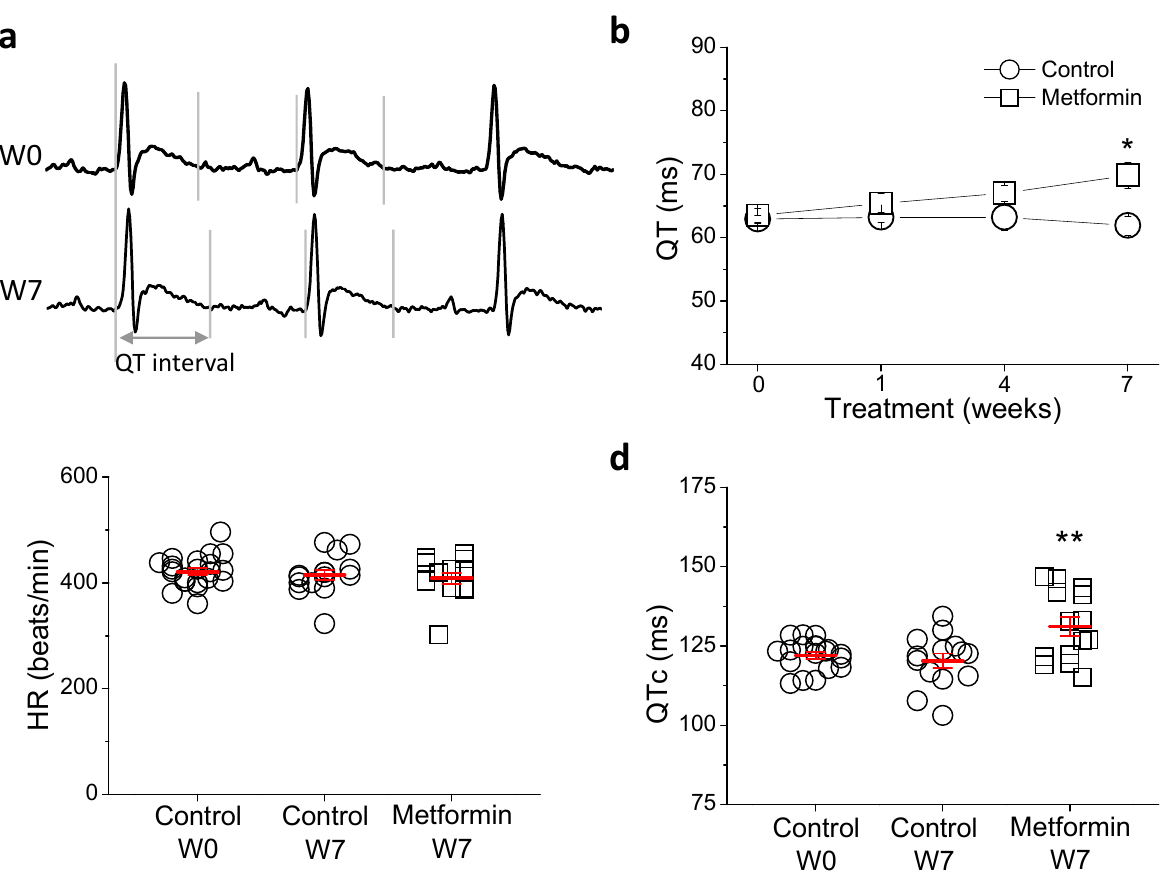
Figure 1. Metformin treatment prolongs QTc interval duration. ( a ) Representative ECGs of a conscious animal before starting (W0) and 7 weeks after (W7) metformin treatment (35 mg/kg × day), grey lines show the QT interval. ( b ) Mean QT interval duration throughout metformin or vehicle treatment. Heart rate ( c ) and QTc interval ( d ), where QT duration is adjusted to heart rate using Fridericia’s formula. Data represent individual data points with mean ± SEM (red marks). * p < 0.05 and ** p < 0.01 compared to control at the same week. (Control W0 n = 22; Control W7 n = 15; Metformin n =